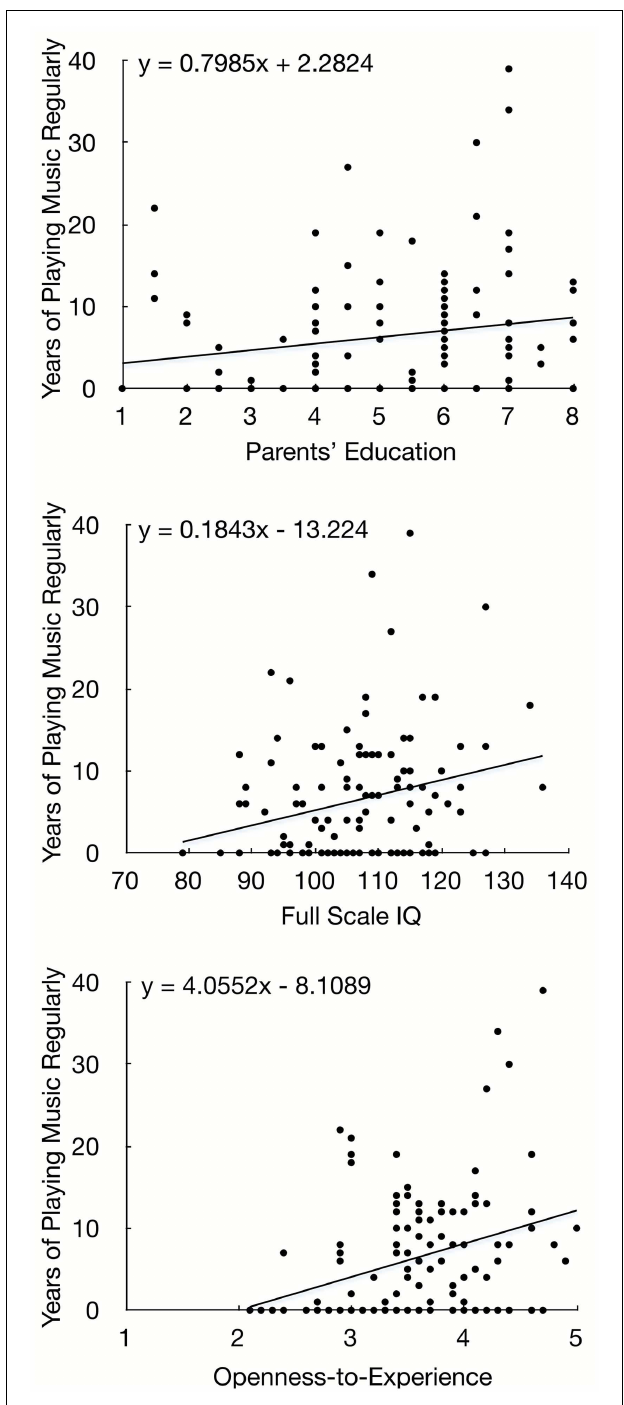
FIGURE 1 | Study 1 (undergraduates): scatterplots of significant simple associations between predictor variables ( X -axis) and playing music regularly ( Y -axis) .